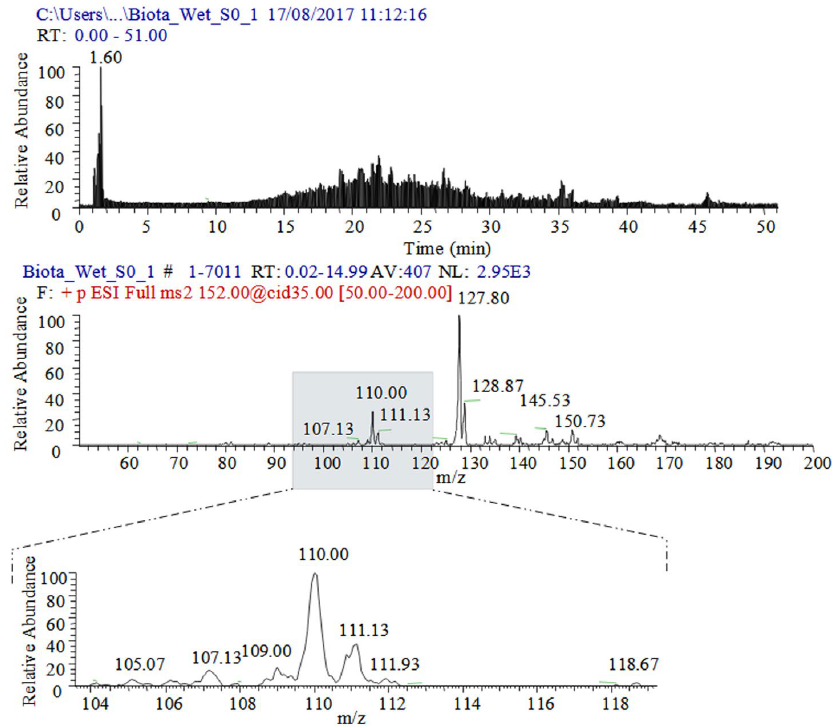
Figure 3. The total ion current ( top ) of standard sample of wet biota; CID - MS/MS spectrum of molecular cation [M+H] + at m / z 152 of paracetamol ( bottom ) .